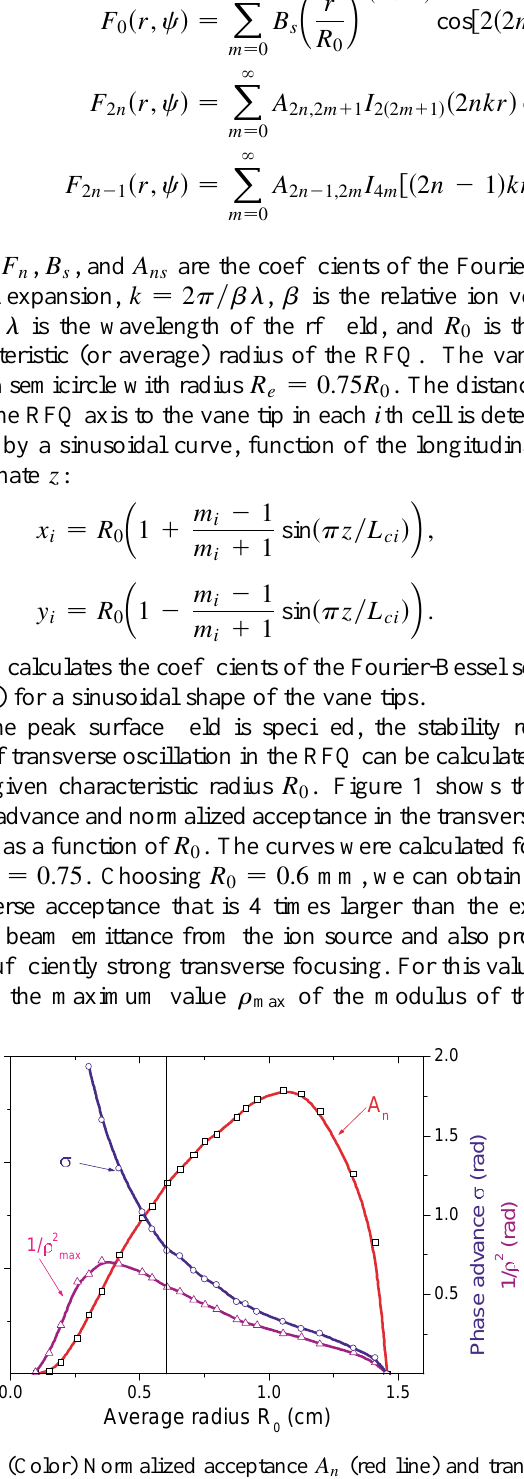
FIG. 1. (Color) Normalized acceptance A n (red line) and trans- verse phase advance s (blue line) calculated for a surface field E max (cid:1) 140 kV (cid:2) cm. The magenta curve represents the parame- ter 1 (cid:2) r 2 max , where r max is the maximum value of the modulus of the Floquet function.